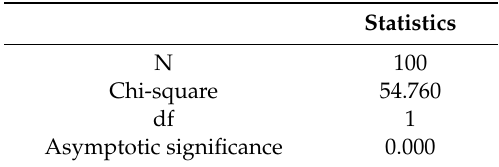
Table 22. Friedman’s test–for two components of CCCI.